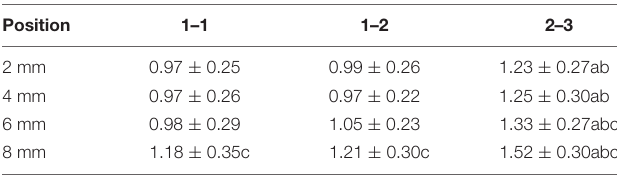
TABLE 4 | CBCT results of labial cortical bone thickness in the mandibular anterior tooth region (mm, ¯ x ± s). Position